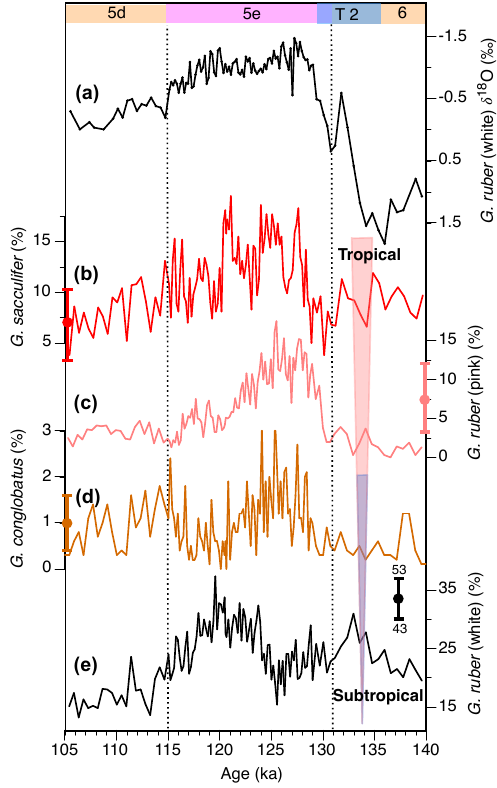
Figure 5. Relative abundances of the main Globigerinoides species in core MD99-2202 over the last interglacial cycle. (a) δ 18 O val- ues in G. ruber (white) (Lantzsch et al., 2007), relative abundances of (b) G. sacculifer , (c) G. ruber (pink), (d) G. conglobatus and (e) G. ruber (white). Also shown in (b–e) are the modern rela- tive foraminiferal abundances (average value ± 1 σ ) around Bahama Bank, computed using the seven nearest samples from the Siccha and Kuˇcera (2017) database. Dashed vertical lines frame MIS 5e. T2 represents Termination